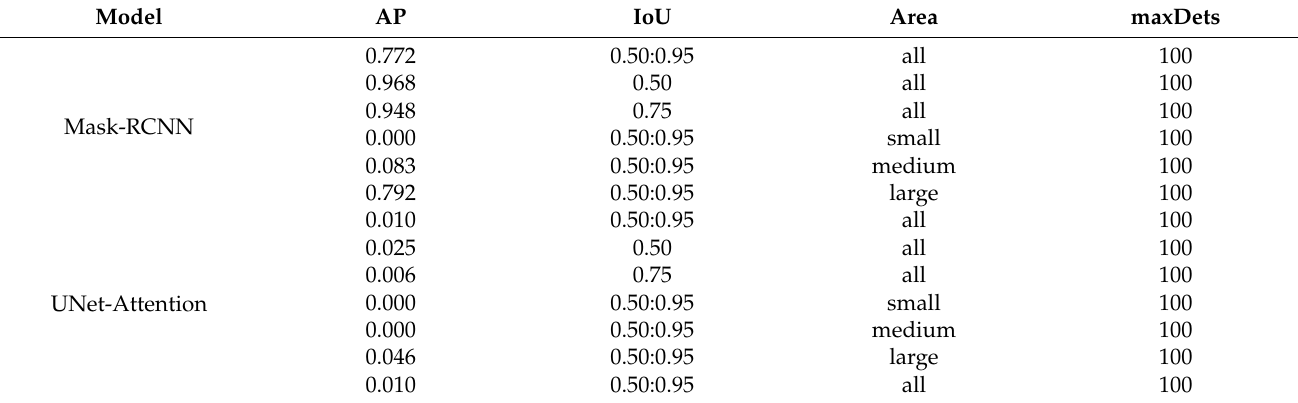
Table 1. The Average Precision (AP) rates of Mask-RCNN and UNet-Attention.